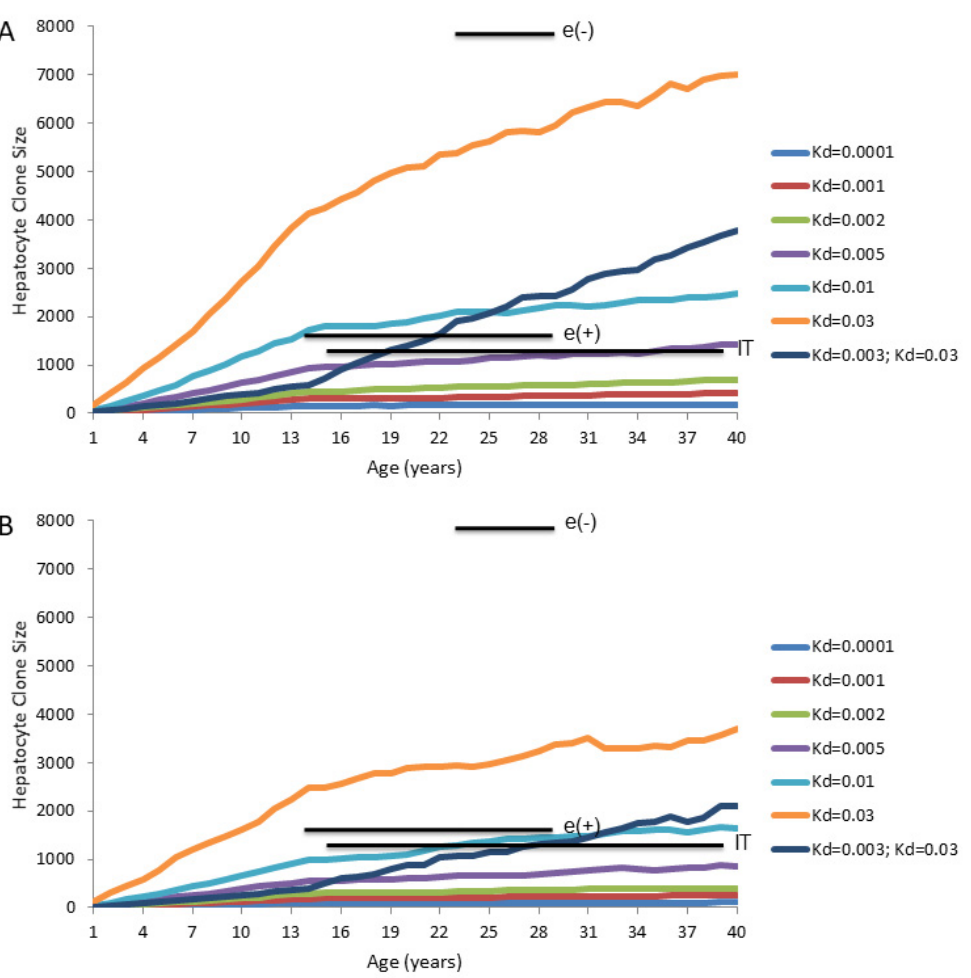
Figure 6. Computer modeling of the predicted emergence of hepatocyte clones in chronically HBV-infected human liver if all hepatocytes are able to proliferate (Model 4): Calculations were made using the program csize8, which was previously described [75]. This program calculates clone size assuming that all hepatocytes are able to proliferate, at random, to maintain liver mass, and that cells are killed at random, with the daily death rates as shown at the right (e.g., Kd = 0.001 means that 0.1% of hepatocytes die per day, and are replaced by compensatory proliferation of surviving hepatocytes). Liver size is assumed to increase 10-fold between birth and maturity at age 14. All hepatocytes (initially 800,000) are assigned unique identifies at birth. In one calculation, the hepatocyte death rate was assumed to be 10-fold lower (0.3% per day; Kd = 0.003) during the first 14 years than after age 14 (3.0% per day; Kd = 0.03). All curves are averages of 10 simulations, with output collected at yearly intervals. The horizontal bars show the geometric mean of maximum hepatocyte clone sizes observed using inverse-nested PCR assays for integrated HBV DNA in a study of three different groups of patients with chronic infection: immune tolerant (IT), immune active, HBeAg-positive (e(+)), and immune active, HBeAg-negative (e(-)) [75]. The bars span the ages covered by each group of patients. ( A ) Predicted maximum clone sizes, assuming 100% of hepatocytes had unique lineage-specific markers at birth. ( B ) Predicted maximum clone sizes if only 1.0% of hepatocytes had detectable lineage-specific markers (e.g., randomly integrated HBV DNA) at birth. Results for predicted maximum hepatocyte clone sizes at different ages are shown for daily hepatocyte death rates of 0.01%, 0.1%, 0.5%, 1% and 3% (equivalent to Kd of 0.0001, 0.001, 0.005, 0.01, 0.03, respectively), which were assumed to be maintained from birth. Mean sizes of the largest hepatocyte clones observed experimentally using assays for integrated HBV DNA in non-cirrhotic liver are also shown for comparison [75]. Interestingly, even for a high and constant hepatocyte death rate (e.g., 0.5% per day, Kd = 0.005) the maximum computed hepatocyte clone sizes are less than the maximum clone sizes experimentally observed in chronically HBV-infected patients using